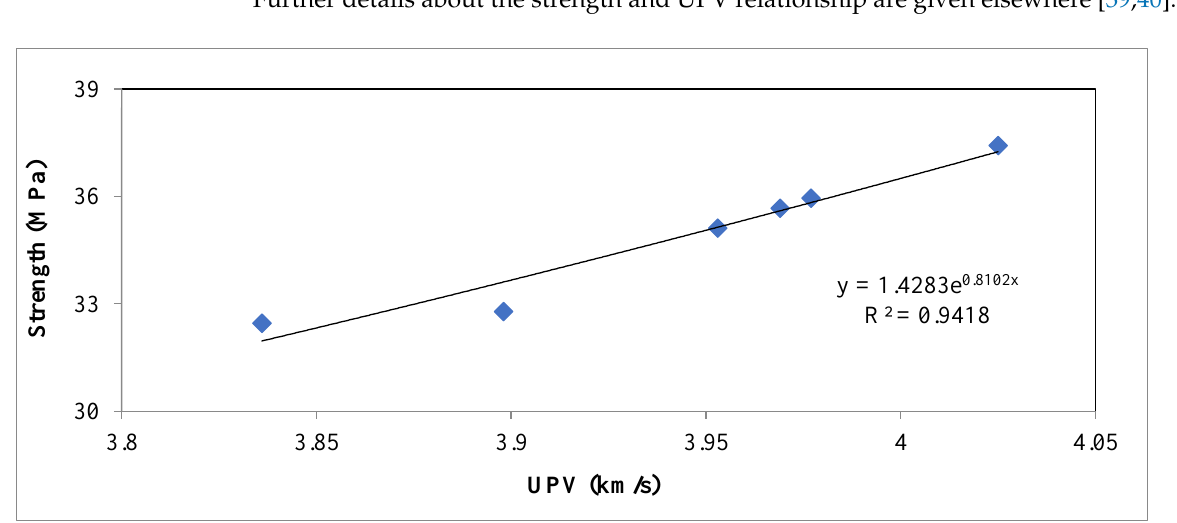
Figure 9. Water absorption of concrete containing different PEG percentages .